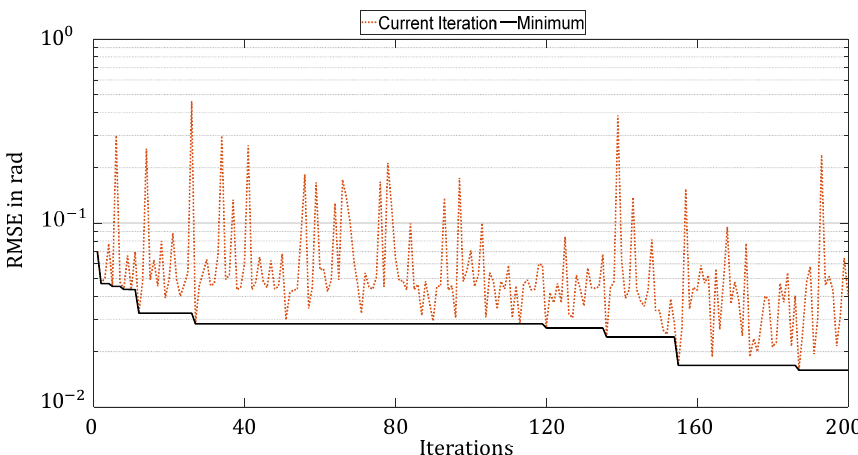
Figure 10. Progress of hyperparameter optimization with the Genetic Algorithm over 5 generations with 40 individuals each, corresponding to 200 training iterations.